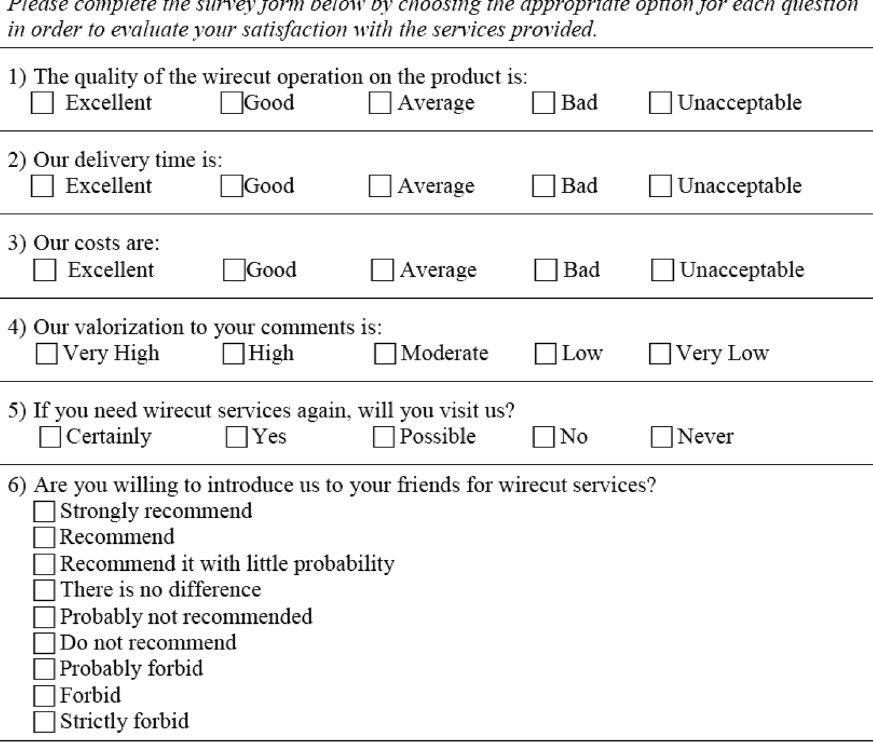
Fig. 2 The Developed questionnaire for customer satisfaction